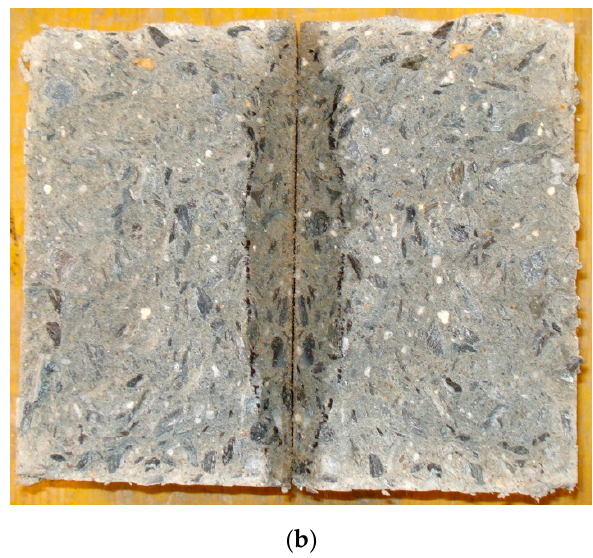
Figure 7 (a) Concrete specimens cut in half made from Bündner Schist (Figure 7a) and (b) Quartz Figure 7. ( a ) Concrete specimens cut in half made from Bündner Schist and ( b ) Quartz Phyllite after Phyllite (Figure 7b) after water penetration testing showing only a short water penetration distance. water penetration testing showing only a short water penetration